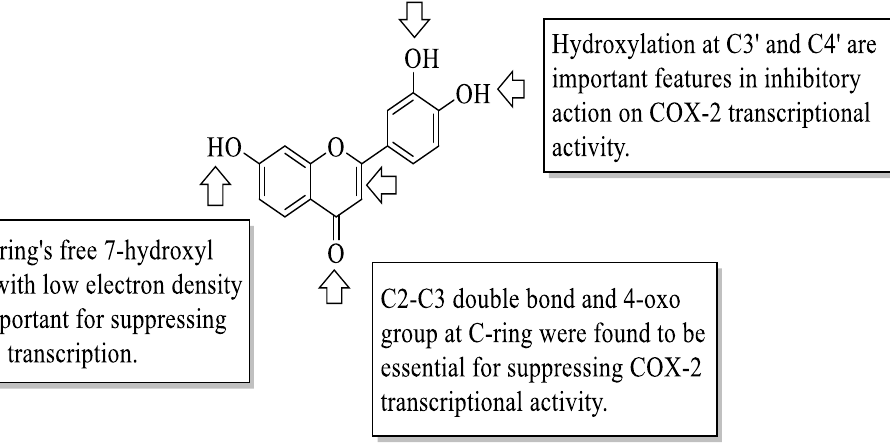
Figure 2. Structure of quercetin ( 1 ) and the labelled functional groups that are important in COX-2 inhibition [25]. inhibition